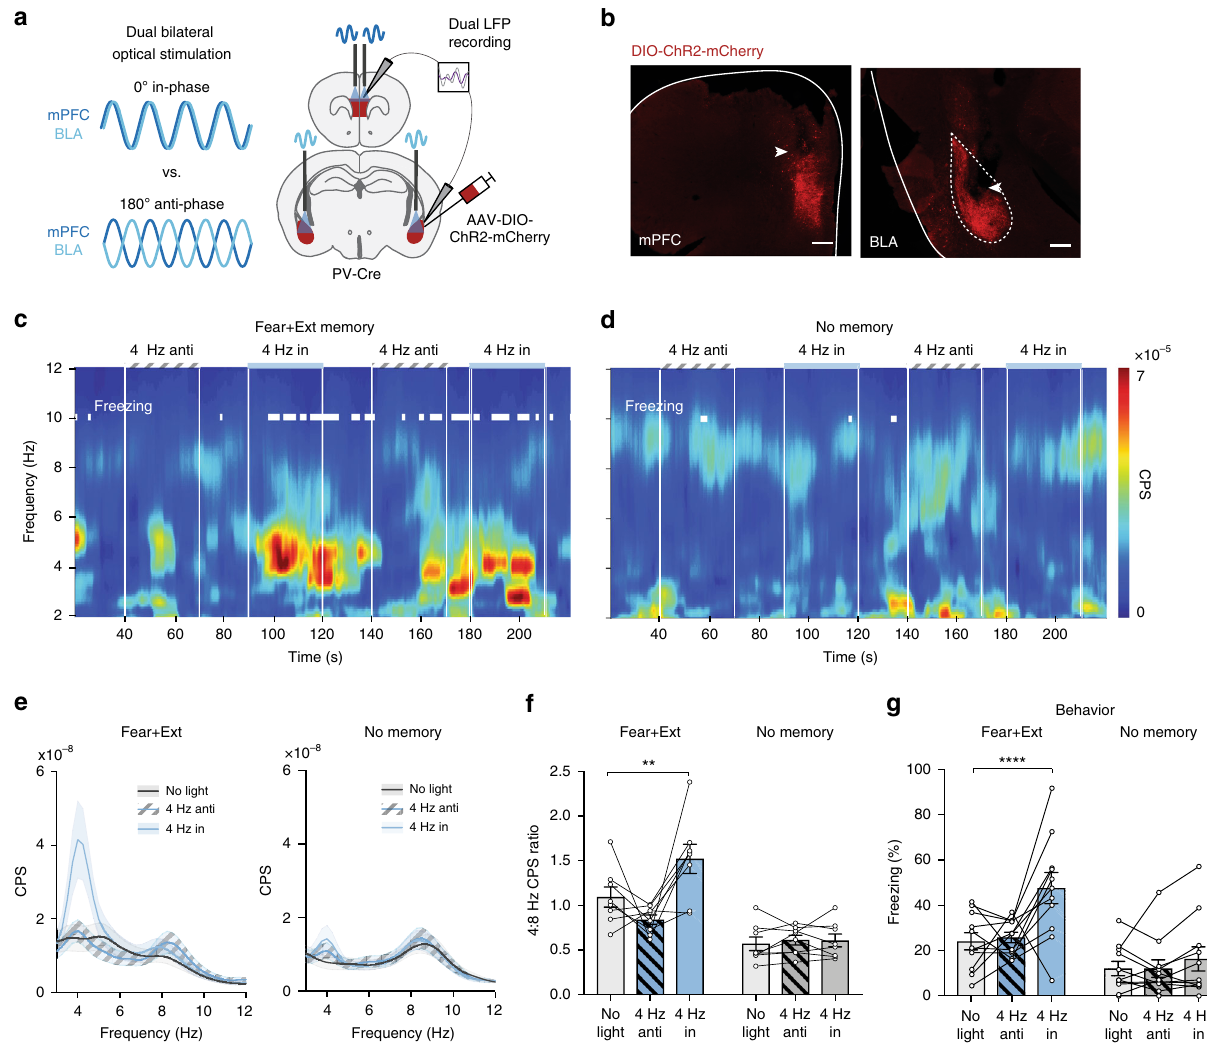
Fig. 7 Anti-phase BLA-mPFC stimulation prevents effects of BLA-only stimulation on memory retrieval. a Schematic of optogenetic strategy to increase frequency-speci fi c functional interactions between the BLA and mPFC. b Example images showing ChR2-mCherry expression, with optical fi ber and electrode placement in mPFC and BLA. Targeting was similarly con fi rmed by histological analysis in all 11 mice; see Methods section for detail. Scale